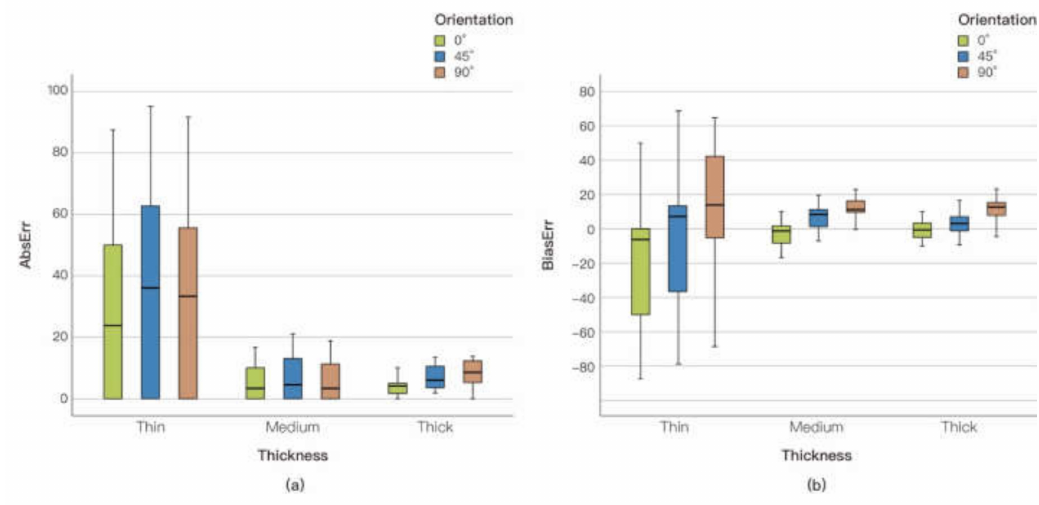
Figure 5. AbsErr ( a ) and BiasErr ( b ) of stimuli with di ff erent orientations and apparent